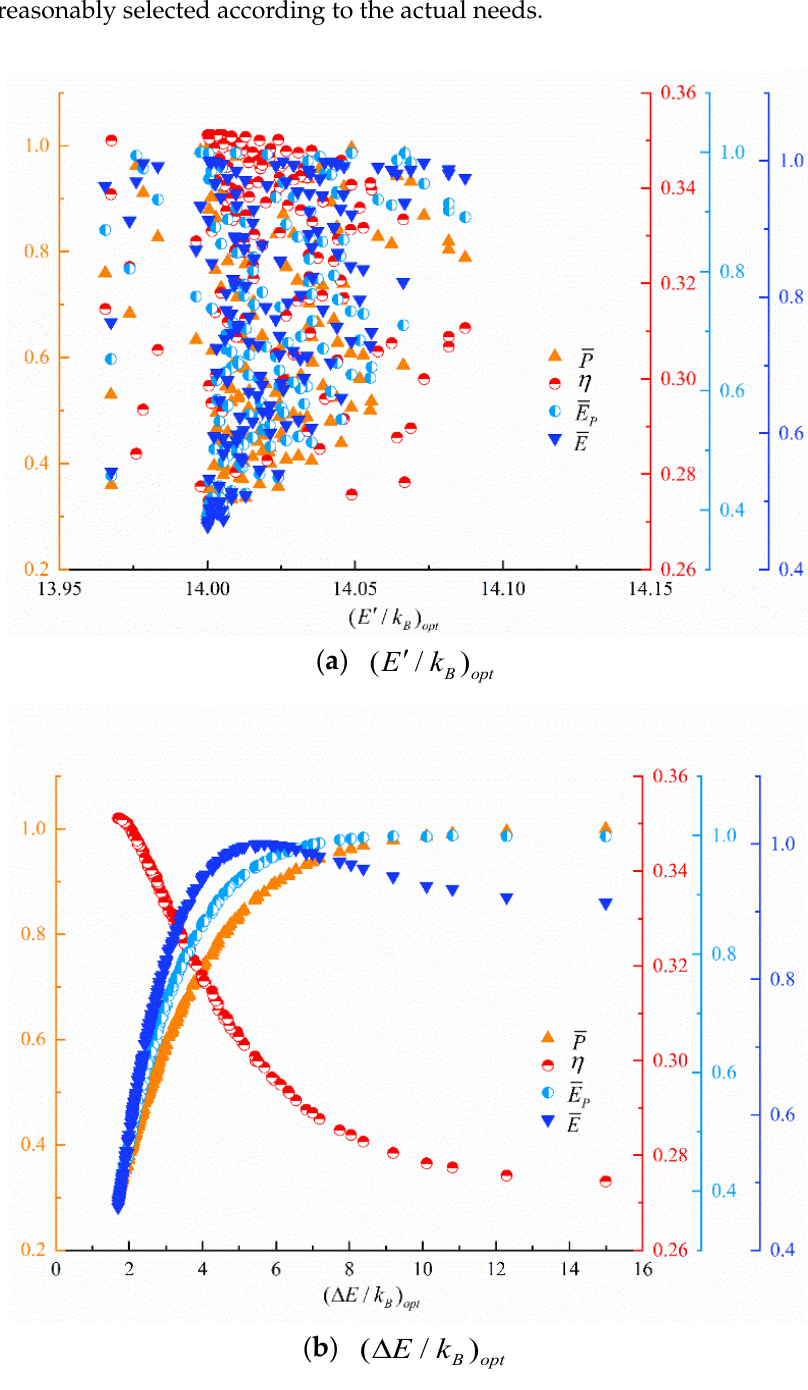
( ∆ E / k ) E k ′ and ( / ) E k ∆ within the value ranges in the Pareto B opt and opt within the value ranges in the Pareto B opt B opt